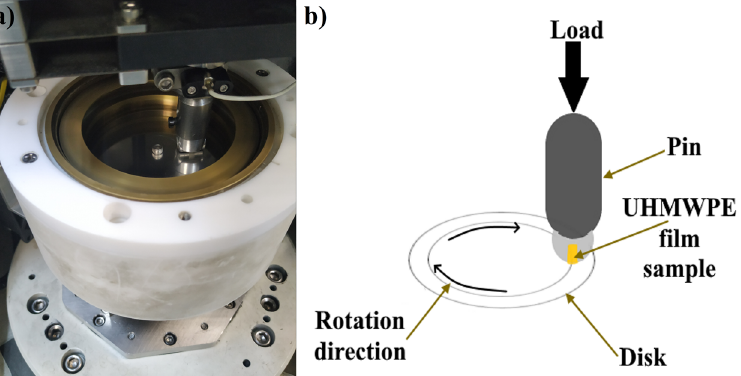
Figure 4. Scheme of the tribological tests: ( a ) the working place of tribometer, ( b ) illustrated draw of the tribological test.